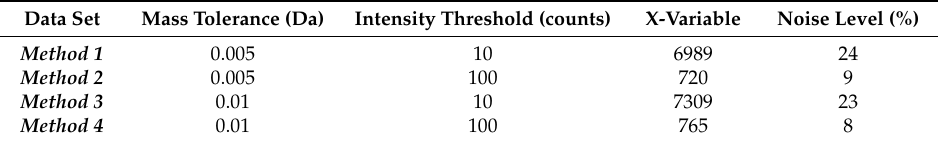
Table 1. Parameters associated with the different datasets generated from MarkerLynx TM processing (Section